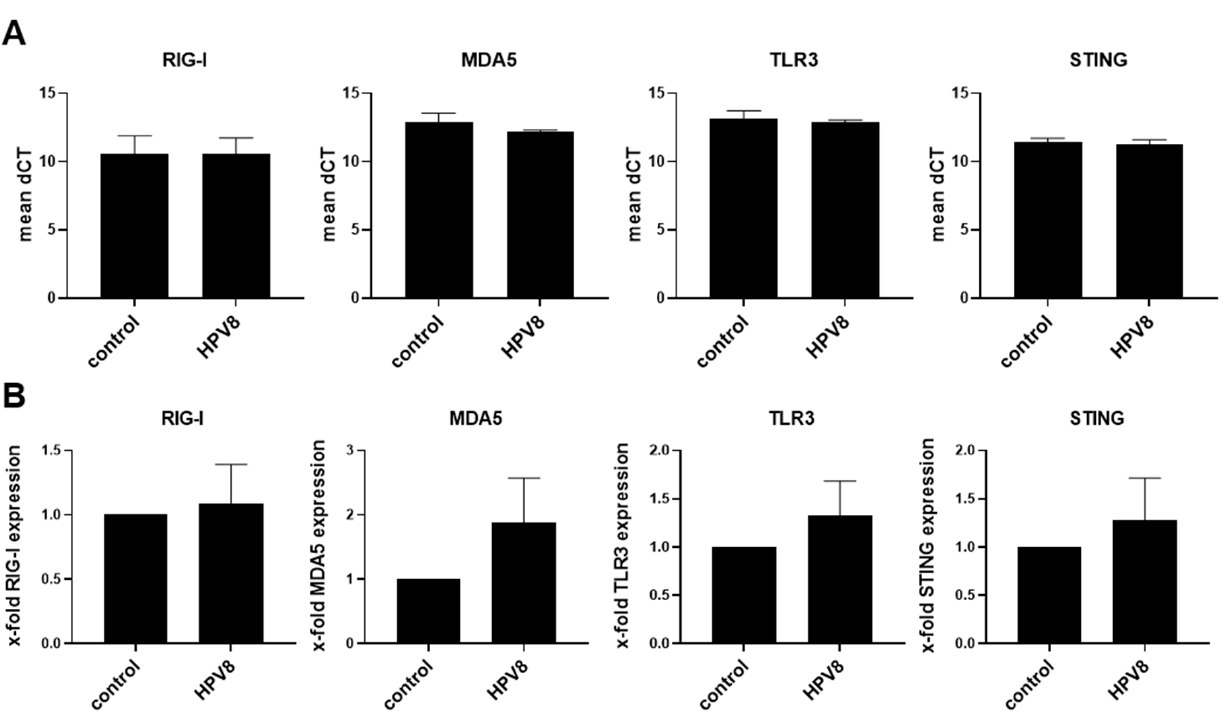
Figure 1. Expression levels of RIG-I , MDA5 , TLR3 , and STING in U2OS cells are not affected by the presence of HPV8. RNA from U2OS cells ± HPV8 was harvested, and RIG-I , MDA5 , TLR3 , and STING mRNA expressions were measured by RT-qPCR using gene-specific primers. Depicted are ( A ) the mean dCT values and ( B ) the x-fold expression levels ± SEM ( n = 3).